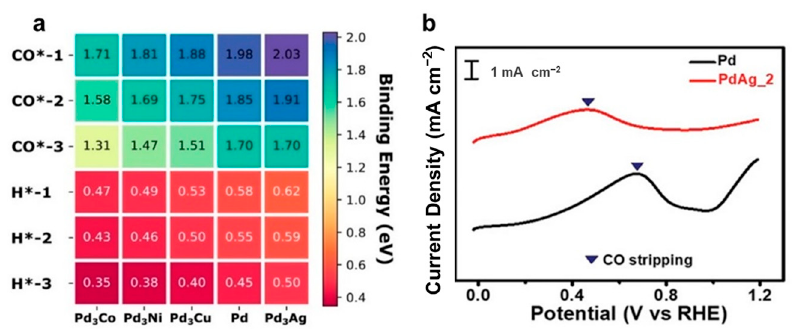
Figure 13. The influence of alloying and the presence of a co-adsorbent upon catalyst deactivation by CO: ( a ) the tabulated binding energies (in eV) of CO to a clean surface (CO*-1), a surface with co- adsorbed H* (CO*-2), and a surface with 2H* (CO*-3), along with the binding of H to a clean surface (H*-1), a surface with H* (H*-2), and a surface with CO* (H*-3) (reproduced with permission from ref. [50], copyright 2019, ACS); ( b ) linear sweep voltammetry of Pd and PdAg_2 immediately after application of a − 0.27 V bias for 1 h in CO 2 -saturated 0.1 M KHCO 3 (reproduced with permission from ref. [51], copyright 2020,